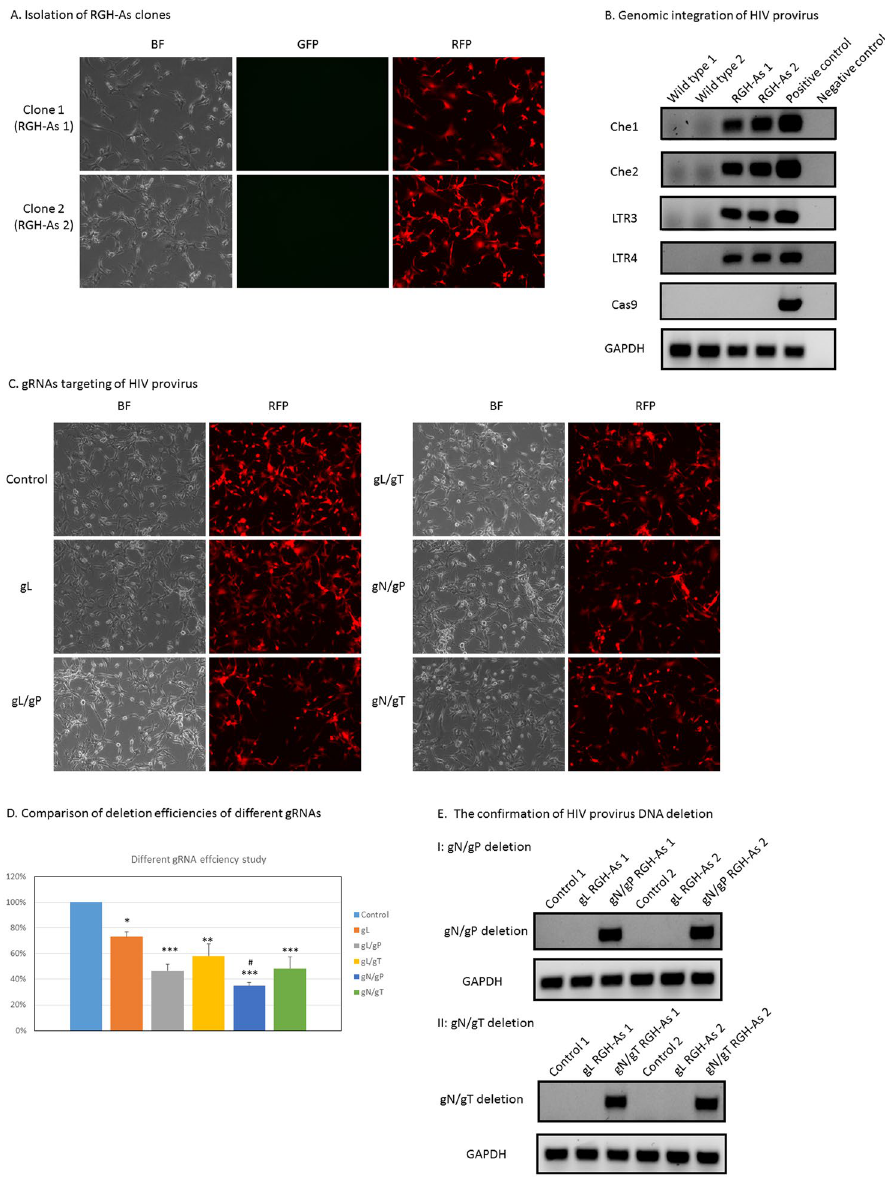
Figure 4. HIV provirus targeting in RGH-As by Cas9 protein and gRNAs complex. ( A ) Isolation of RGH-As clones. Wild type astrocytes were infected with VSVG pseudotyped RGH. Latent HIV astrocyte clones were isolated and examined by fluorescent microscopy. ( B ) Genomic integration of HIV provirus. Multiple HIV provirus specific primers were used to verify the genomic integration of HIV provirus in selected two clones. Gapdh PCR products were used as a DNA extracts quality and loading control. Cas9 construct PCR was used to confirm the absence of Cas9 construct. Two clones were used in each test. ( C ) gRNAs targeting of HIV provirus. The selected RGH-As was treated with different gRNAs which targeted different regions of HIV provirus. Successful targeting resulted in the termination of red fluorescent protein expression. Here presented a representative microscopy image of each treatment. ( D ) Comparison of deletion efficiencies of different gRNAs. The microplates of different gRNA treated cells were read by a conventional plate reader. The red fluorescent protein expression levels were normalized by the protein expression level of the control group. The protein expression level of control group was presented as 100%. The figure presented the data of four different experiments. The results were expressed by mean ± SEM. Each treatment was compared to the control by one-way ANOVA followed by Dunnett’s multiple comparison test. Note: * means P < 0.05; ** means P < 0.01; *** means P < 0.001. All two pairs comparison were conducted by one-way ANOVA followed by Turkey multiple comparison test. Note: # means P < 0.05 when compared to gL group. ( E ) The confirmation of HIV provirus DNA deletion. After gRNA treatment, RGH-As DNA samples were extracted. Specific PCR primers were used to detect HIV provirus DNA deletion. A band at a specific size indicated the positive results of DNA deletion I: gN/gP deletion presented the HIV provirus DNA segment deletion with gN and gP treatment; II: gN/gT deletion presented the HIV provirus DNA segment deletion with gN and gT treatment. Two different experimental samples were used in each